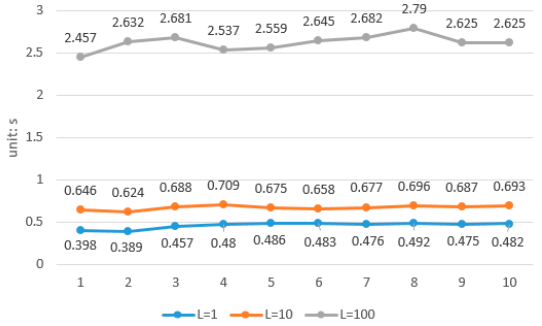
Figure 16. Optimal potential field method path-planning time for three L values.